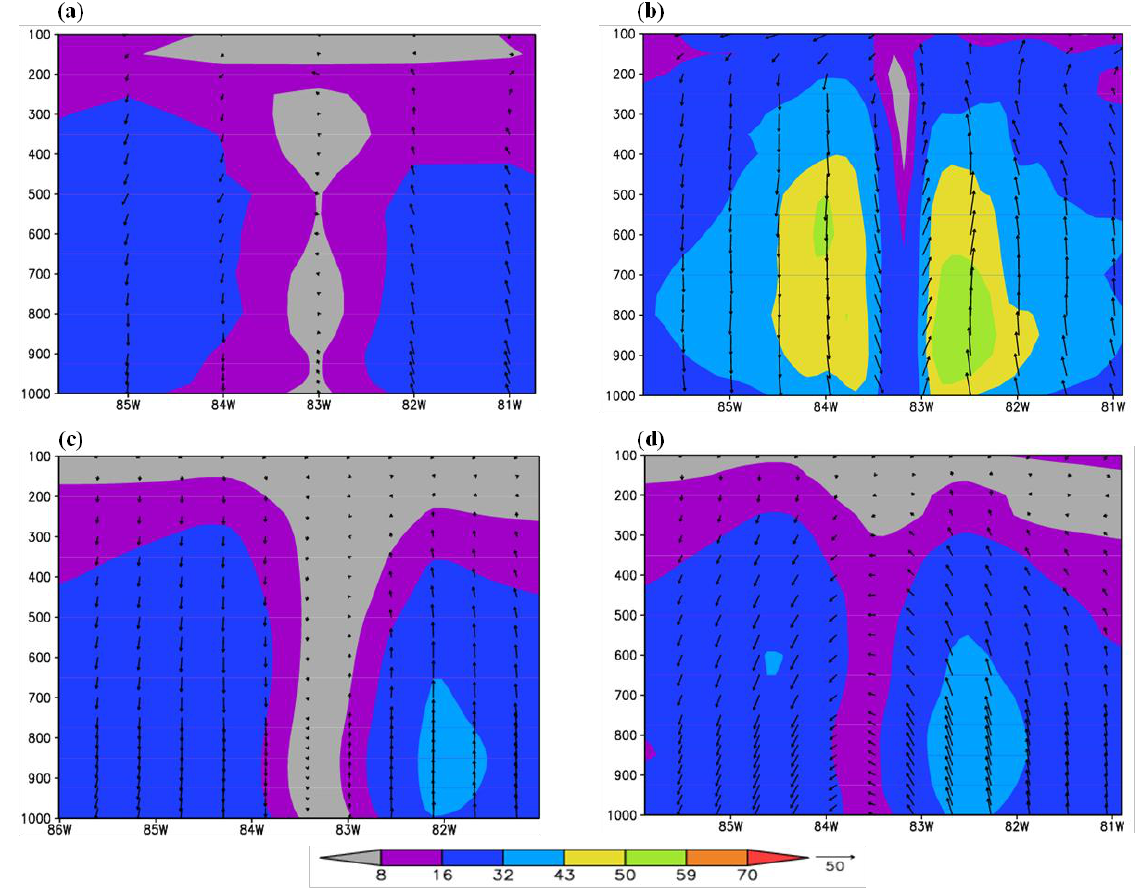
Figure 4. Longitude- vertical sections of horizontal wind with magnitude (shaded) and wind vectors (black barbs) at the model initial time of 0000 UTC 27 August 2005 (a) along 25N-FNL analysis, (b) along 24.7N-HWRF model, (c) along 24.3486N-ARW model, (d) along 24.785N-NMM